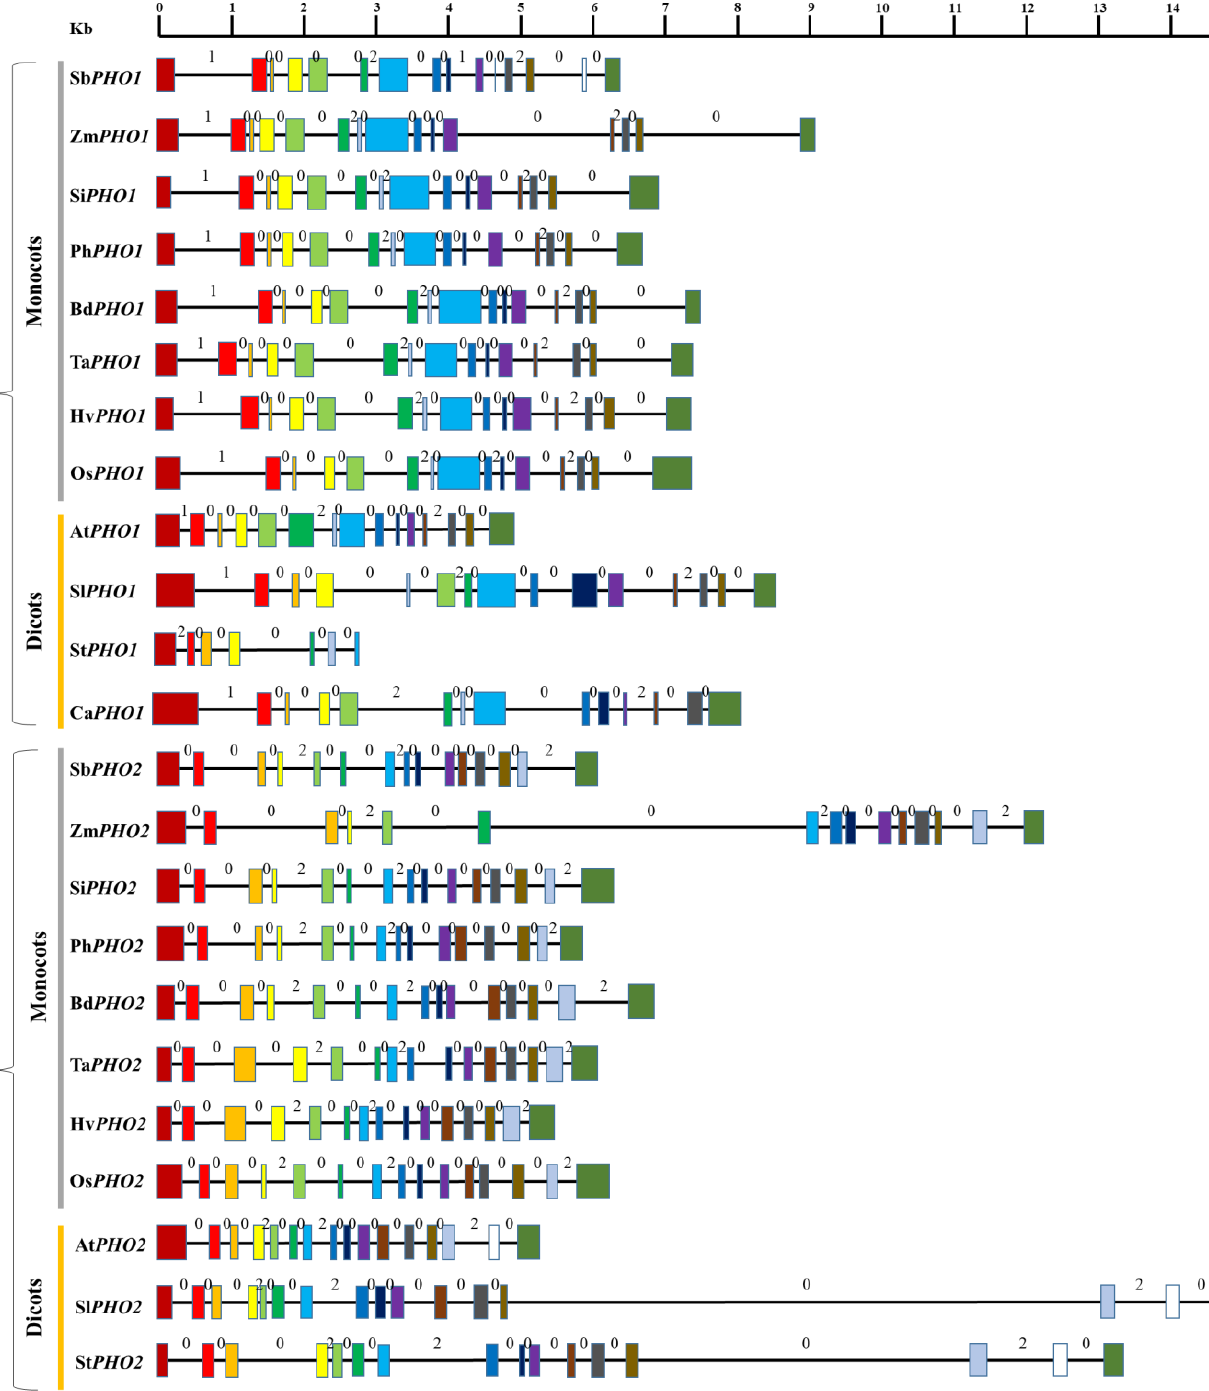
Figure 1. Gene structure of PHO1 and PHO2 from the translation start to stop sites in various monocots and dicots. Symbols include: Sb, Sorghum bicolor ; Zm, Zea mays ; Si, Setaria italica ; Ph, Panicum hallii ; Bd, Brachypodium distachyon ; Ta, Triticum aestivum ; Hv, Hordeum vulgare ; Os, Oryza sativa ; At, Arabidopsis thaliana ; Sl, Solanum lycopersicum ; St, Solanum tuberosum ; and Ca, Capsicum annuum . Solid boxes indicate the exons, and lines indicate the introns. Colors represent the similarities among respective exons as a reference to O. sativa . The values of zero, one, and two marked above each intron are intron phases.